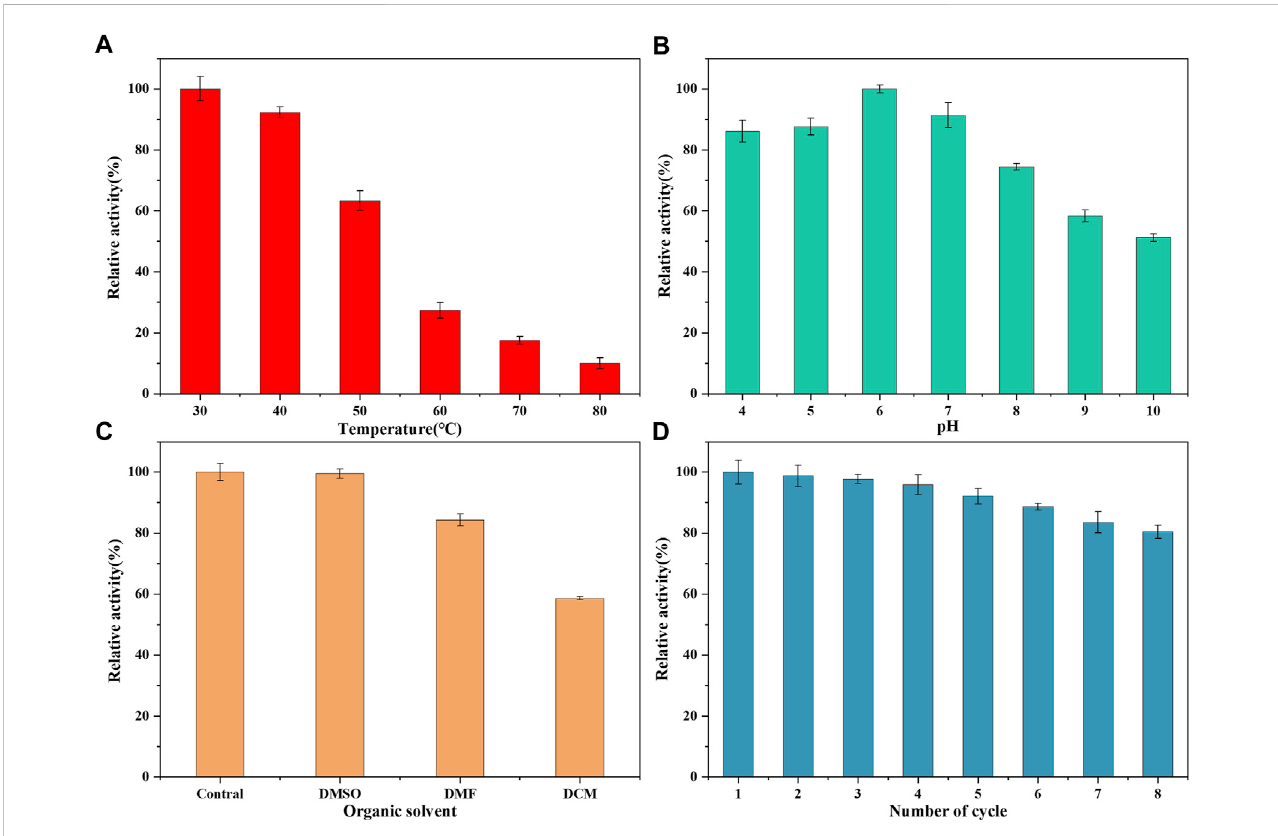
FIGURE 9 (A) ActivityofLDH/MNPs@MAF-7afterincubationattheindicatedtemperaturesfor20 min (B) ActivityofLDH/MNPs@MAF-7afterincubationatdifferent pH values for 20 min (C) Organic solvent stability of LDH/MNPs@MAF-7 (D) Reusability of LDH/MNPs@MAF-7 up to the 8th reuse